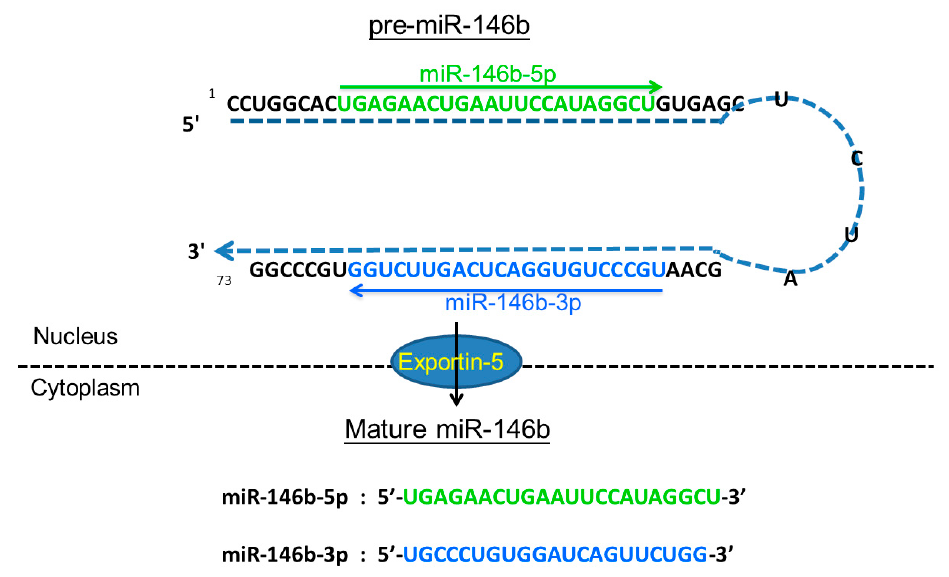
Figure 1. The hairpin structure of pre-miR-146b and the sequence of mature miR-146b. The MIR146B gene is located in an intergenic region of chromosome 10q24.32 and transcribed into a precursor (pre-miR-146b) with 73 nucleotides in the nucleus, that is exported to the cytoplasm by Exportin-5 for additional processing to yield two mature microRNAs with 22 nucleotides, miR-146b-5p and miR-146b-3p. The sequence of mature miR-146b-5p and miR-146b-3p is colored in green and blue. The arrow shows the orientations from 5 ′ to 3 ′ .